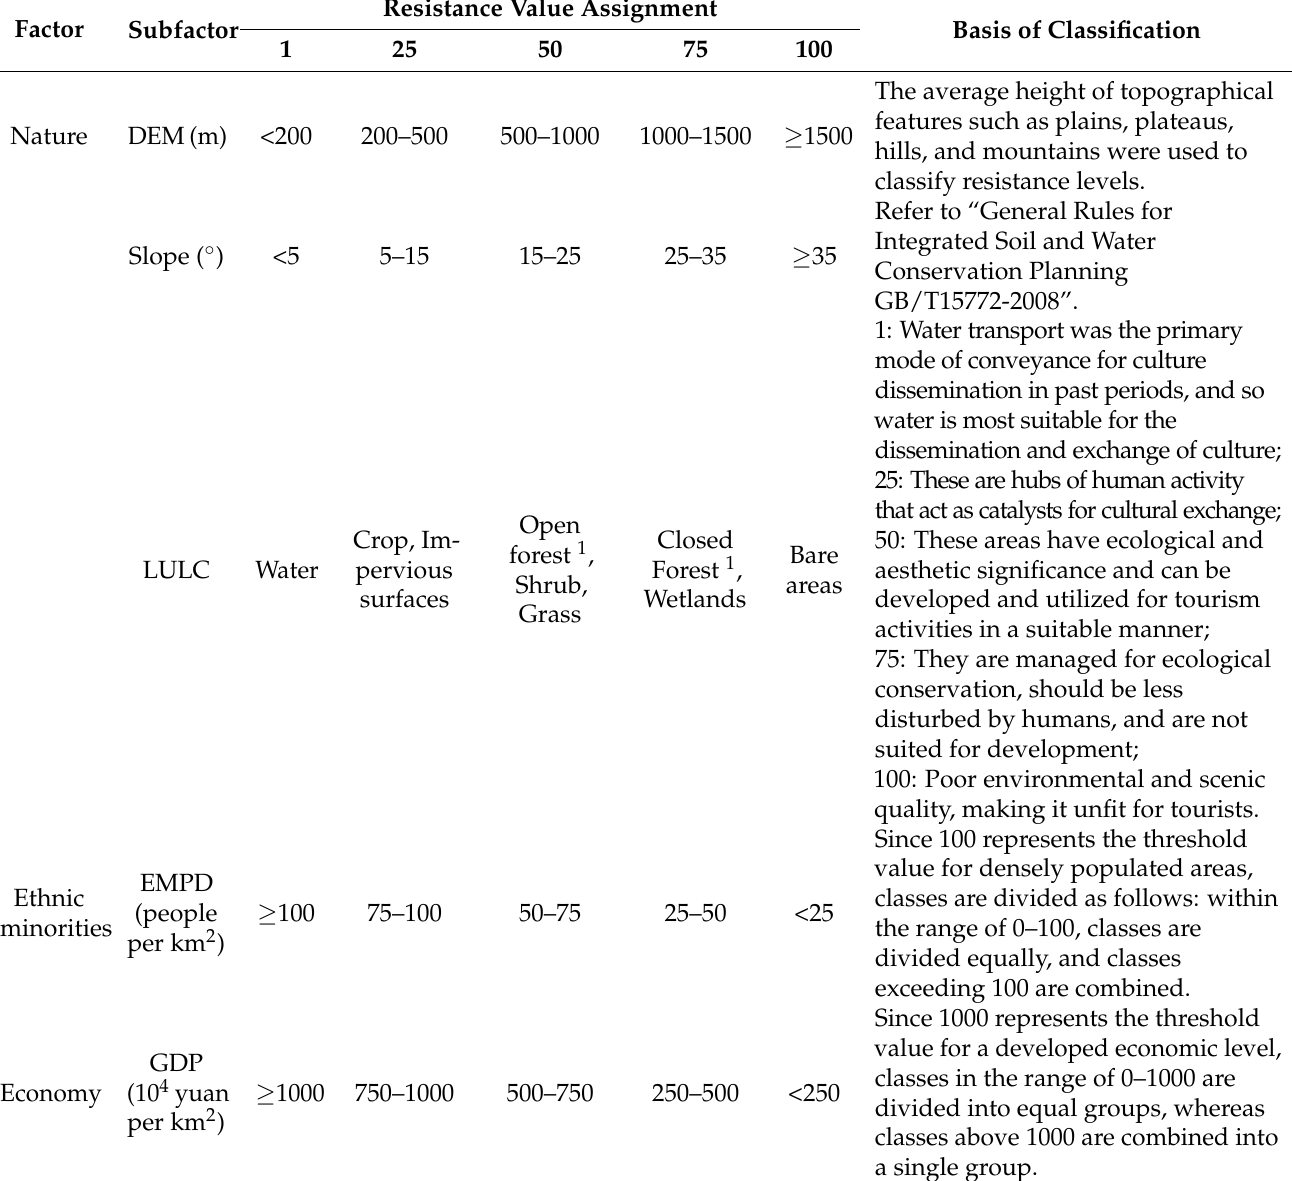
Table 2. A framework for evaluating cultural dissemination resistance, including the assignment of resistance values and the reason for the